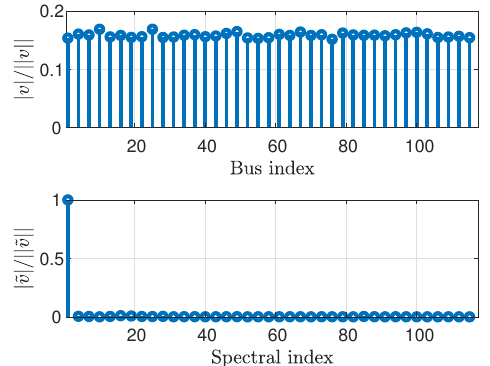
Figure 2. The voltage magnitude vector ( top ) and its GFT ( bottom ) for the IEEE 118-bus system.